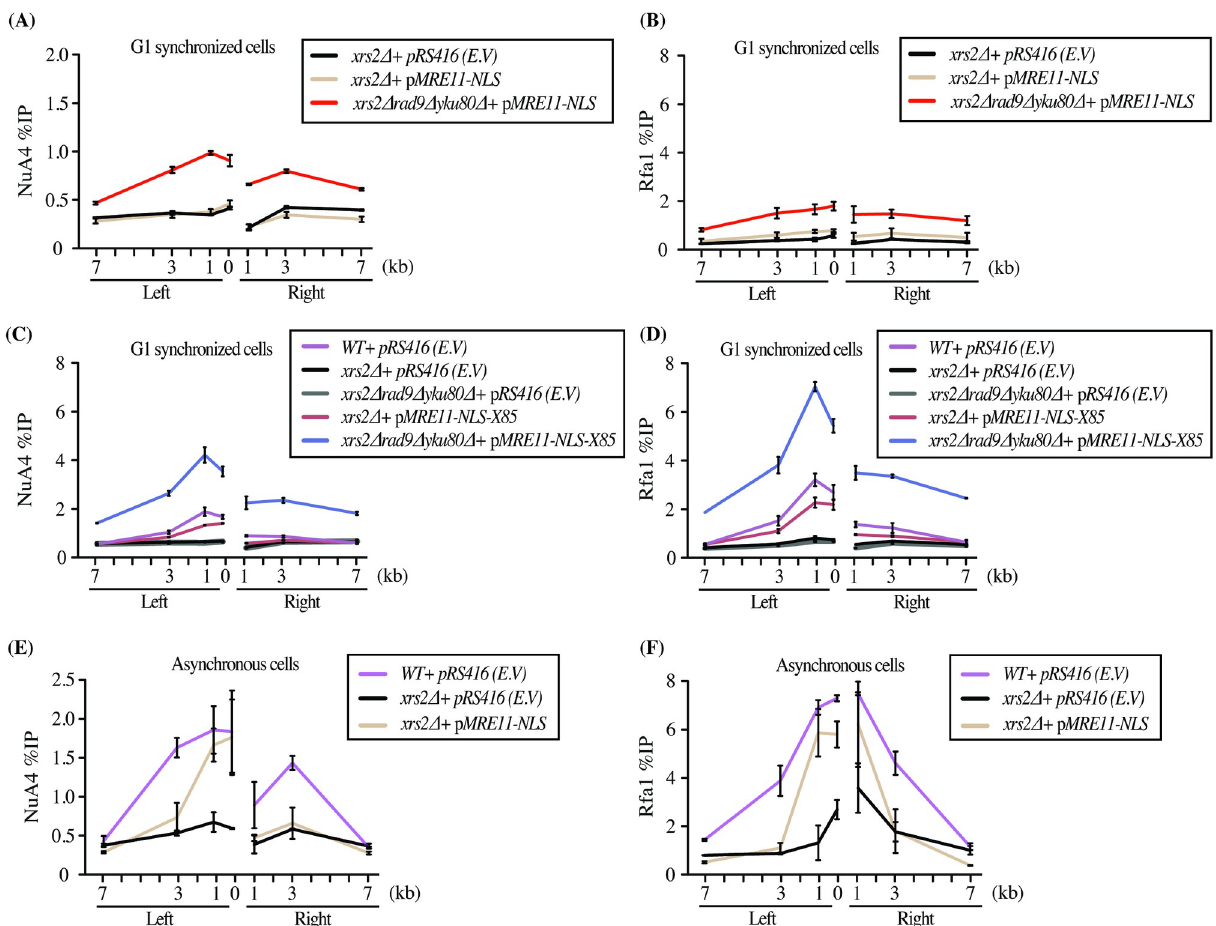
Fig 3. Alternate mode of NuA4 recruitment in G1 in conditions of Xrs2 functional bypass. (A-B) Resection and NuA4 recruitment is partially restored in the xrs2 Δ rad9 Δ y ku80 Δ background with expression of Mre11-NLS from a low copy number ARS:CEN plasmid. ChIP-qPCR of Eaf1 and Rfa1 was performed as in (Fig 1) in cells synchronized in G1. (C-D) Resection and NuA4 recruitment is largely restored in xrs2 Δ rad9 Δ y ku80 Δ background by expression of Mre11-NLS-X85 that more fully bypasses Xrs2 functions. (E-F) Expression of Mre11-NLS also partially rescues NuA4 recruitment and resection (Rfa1 signal) in the xrs2 Δ background in asynchronous cells (on the left side proximal to the DSB site). (See S3 Fig for xrs2 Δ phenotypic suppression by Mre11-NLS and HO-cutting efficiencies).